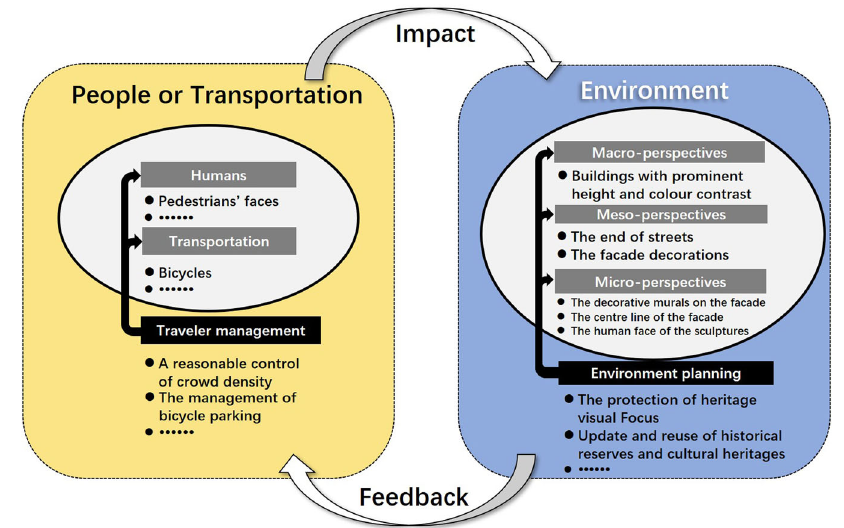
Fig. 19 The diagram of the application of the distribution of visual focus for